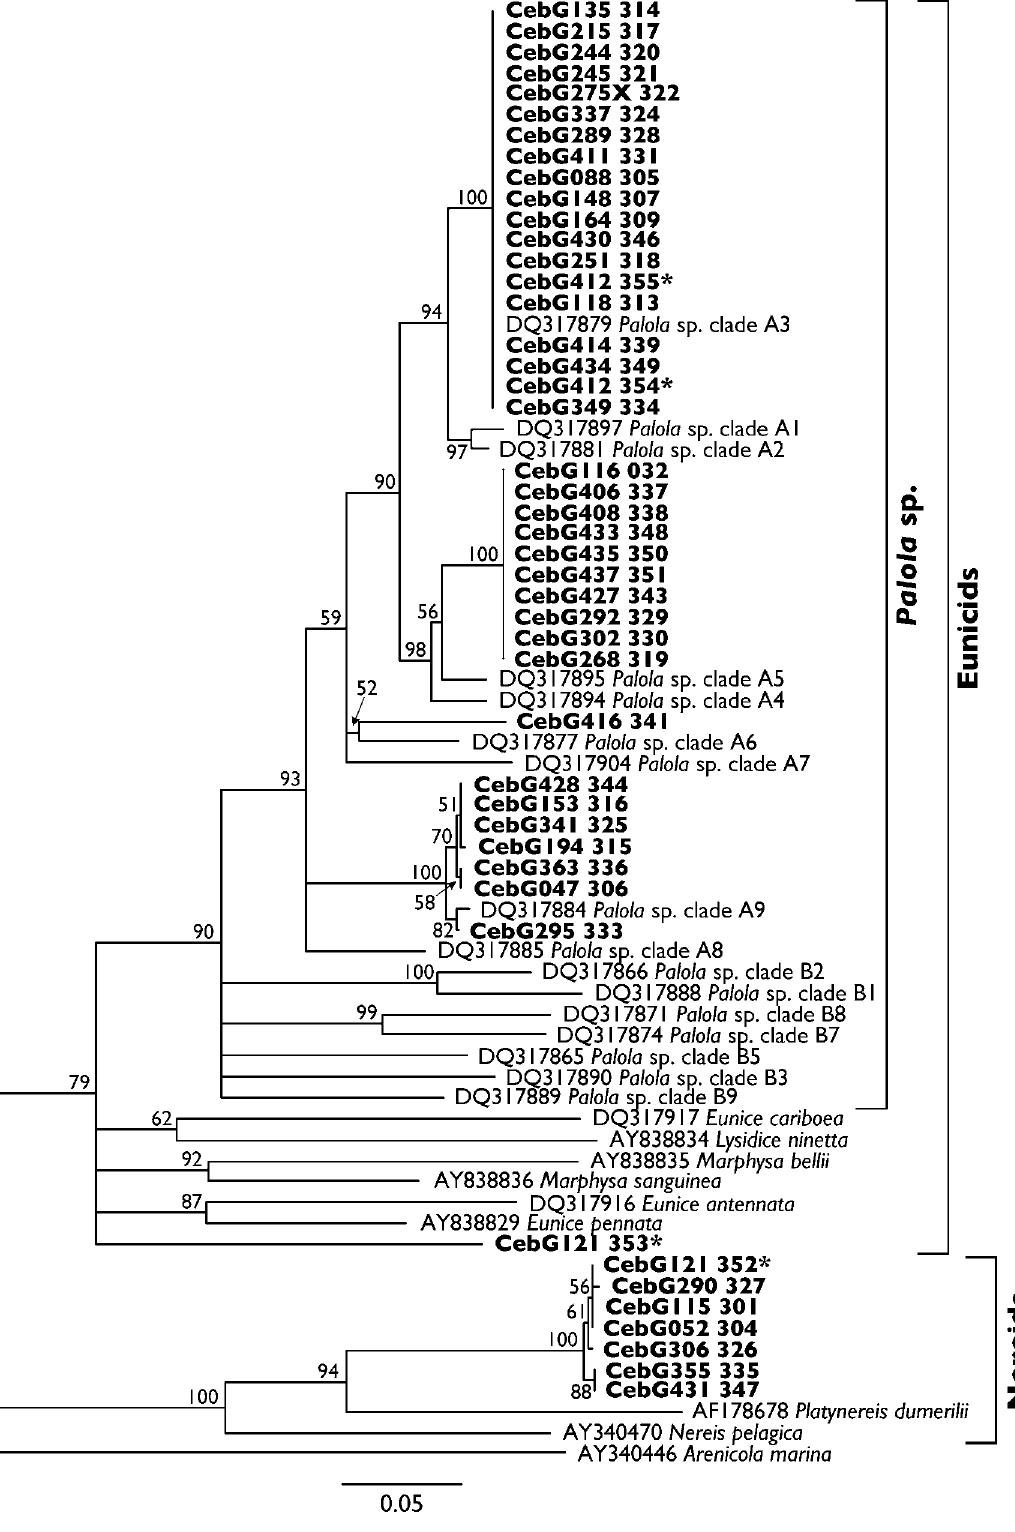
Figure 4. Neighbor-joining tree constructed from Kimura 2-parameter distances [ 48 ] of sequences of a region of the mitochondrial 16S gene. Bootstrap values from 1000 replicates are presented on branches; branches with bootstrap values less than 50% were collapsed. The tree is rooted to a sequence from Arenicola marina (Order Capitellida, Family Arenicolidae). Sequences obtained from feces are indicated in bold; names include the specimen code and fecal sample number. Names of sequences of polychaetes from GenBank are given with their GenBank accession numbers. Sequences from fecal materials of CebG121 and CebG412, the two individuals that defecated twice over a 24-hour period, are indicated with asterisks. doi:10.1371/journal.pone.0006245.g004 PLoS ONE | www.plosone.org